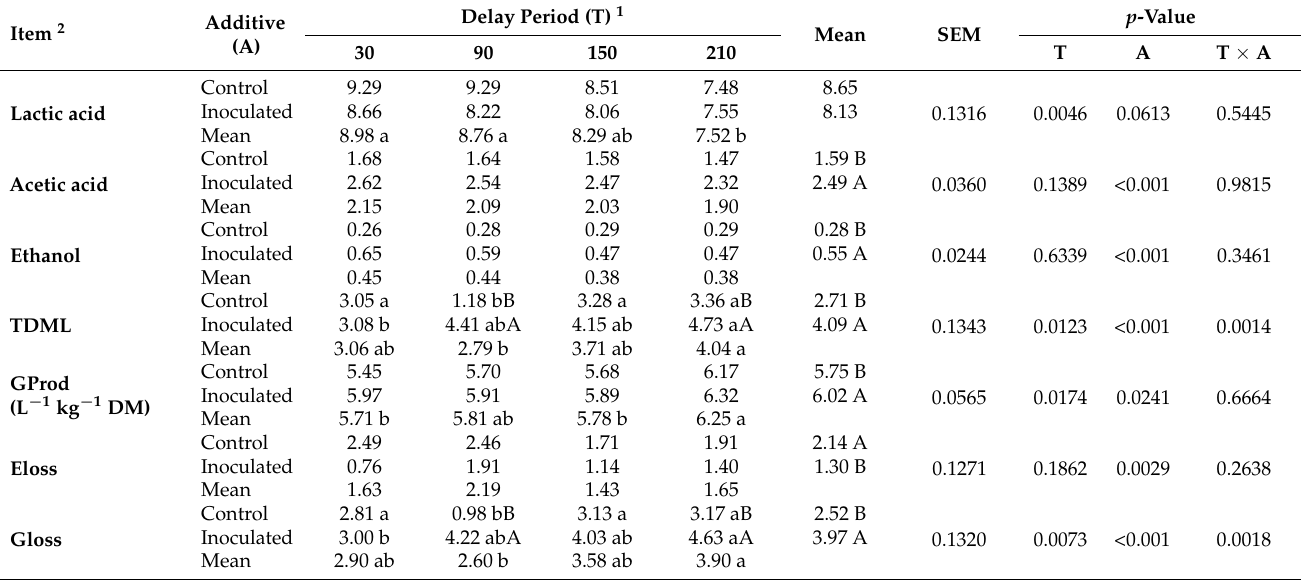
Table 2. Effect of ensiling time and inoculant on fermentation products, DM loss, gas production, and effluents.